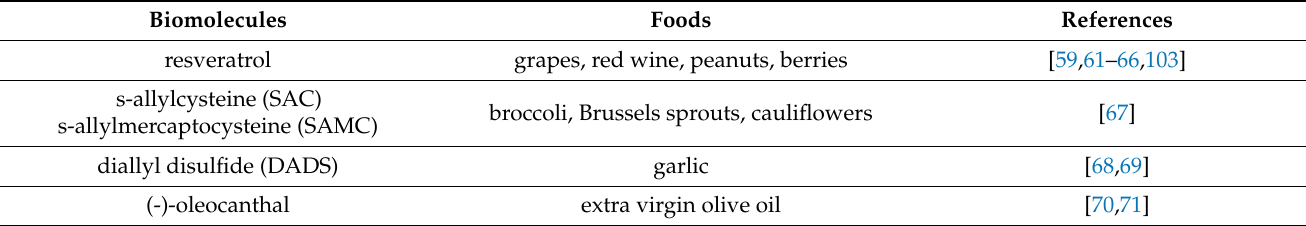
Table 1. Biomolecules selected in the present discussion, foods that contain them, and references that report their role in countering processes involved in bone